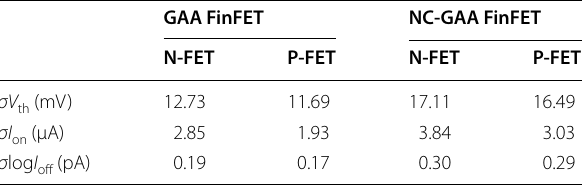
, I and I for N‑/P‑type th on off 102) =